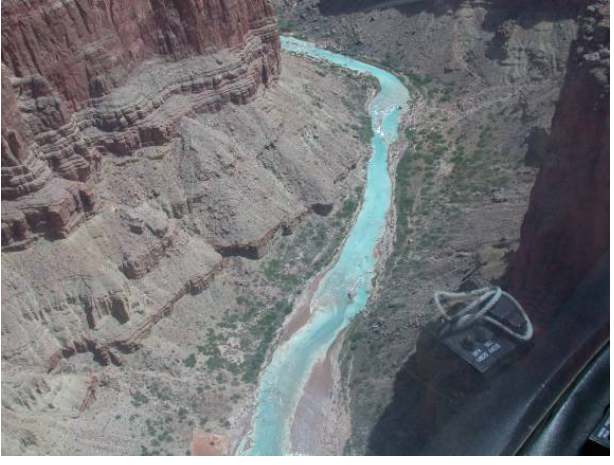
Fig. 5 . Oblique aerial view looking upstream into the lower Little Colorado River gorge, which is critical tributary spawning habitat for the endangered humpback chub in Grand Canyon National Park. (Credit: T. S.